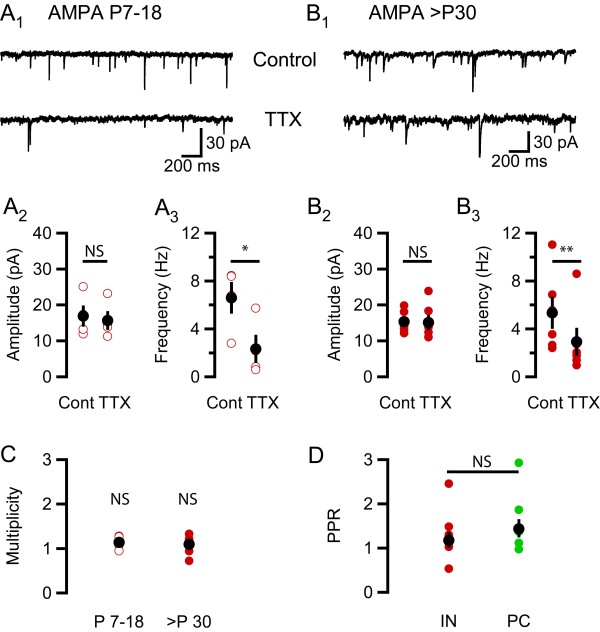
No developmental change in multiplicity at glutamatergic synapses onto interneurons in stratum radiatum. (A1) A typical recording at -80 mV from an interneuron in stratum radiatum from a P17 rat, upper trace shows AMPA sEPSCs under control conditions and lower trace shows mEPSCs after wash-in of TTX. (A2) At ages P7 - P18, TTX does not change the AMPA EPSC amplitude (an average reduction of 1.2 ± 0.8 pA, P = 0.2, n = 4, two-tailed paired t-test). (A3) TTX reduces AMPA EPSC frequency by 4.3 ± 1.1 Hz (P = 0.01, n = 4, one-tailed paired t-test). (B1) A typical recording at -80 mV from an interneuron in stratum radiatum from a P50 rat, upper trace shows AMPA sEPSCs under control conditions and lower trace shows mEPSCs after wash-in of TTX. (B2) At ages P30 - P50, TTX does not affect the AMPA EPSC amplitude (an average reduction by 0.3 ± 0.9 pA, P = 0.8, n = 6, two-tailed paired t-test). (B3) TTX reduces AMPA EPSC frequency by 2.4 ± 0.5 Hz (P = 0.003, n = 6, one-tailed paired t-test). (C) The average multiplicity was 1.1 ± 0.1 (P = 0.09, n = 4, one-tailed one-sample t-test with test value = 1) for the young age group (P7-18, open circles) and 1.1 ± 0.1 (P = 0.17, n = 6) for the older rats (> P30, filled circles). (D) PPR measurements from 8 interneurons in stratum radiatum (red filled circles) and 7 pyramidal cells (green filled circles). The average PPR (50 ms) for the interneurons in stratum radiatum is 1.17 + 0.19/- 0.16 (geometric mean +/- SEM) and for the pyramidal cells 1.43 + 0.22/- 0.19 (P = 0.4, two-tailed Student's t-test). Black filled circles show mean ± SEM and green and red open and filled circles show individual experiments. Asterisks denote the level of significance as follows: *: P < 0.05, **: P < 0.01.